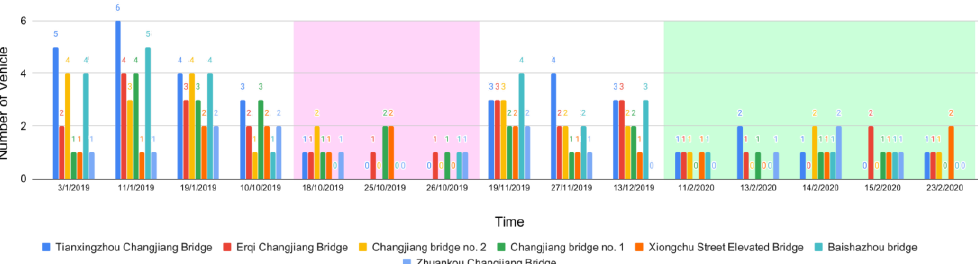
Figure 14. Vehicle trend before, during, and after the 7th International Military Sports Council (CISM) Military World Games and Coronavirus Disease of 2019 (COVID-19) lockdown along the 7 bridges, estimated based on the COSMO-SkyMed data analysis. Purple color shade shows the 7th CISM Military World Games period and green color shade shows the COVID-19 lockdown period.